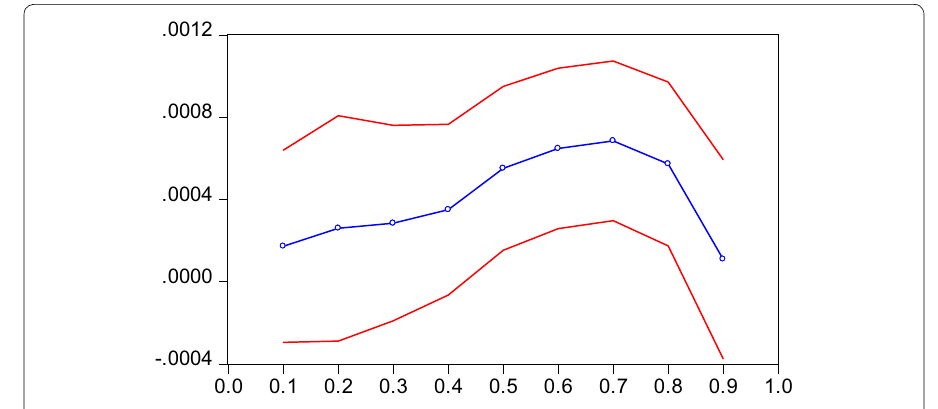
Fig. 2 Quantile estimations of ( r